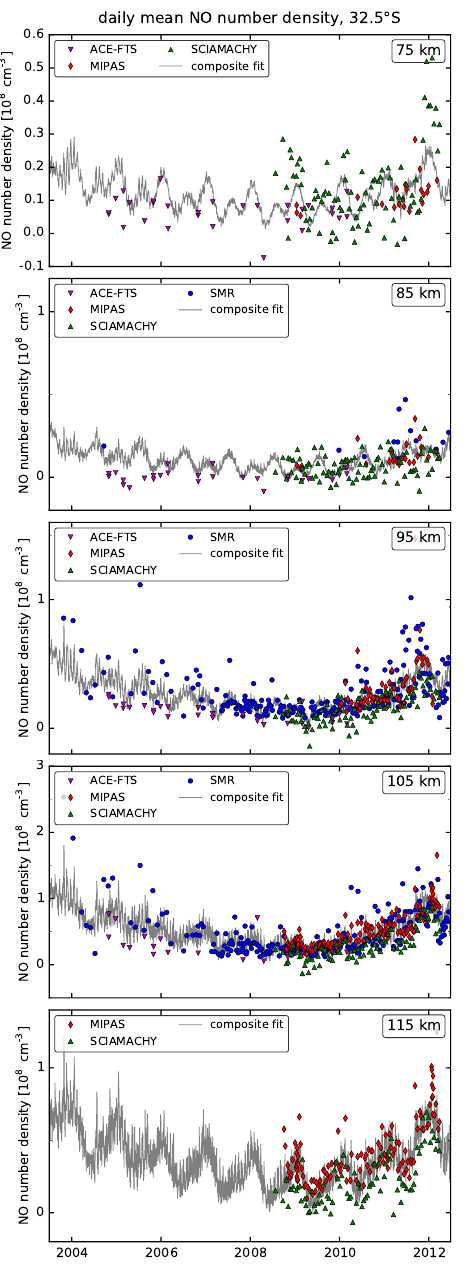
Figure C3. NO time series regression results at 32.5 ◦ S, for 75km, 85km, 95km, 105km, and 115km (from top to bottom).